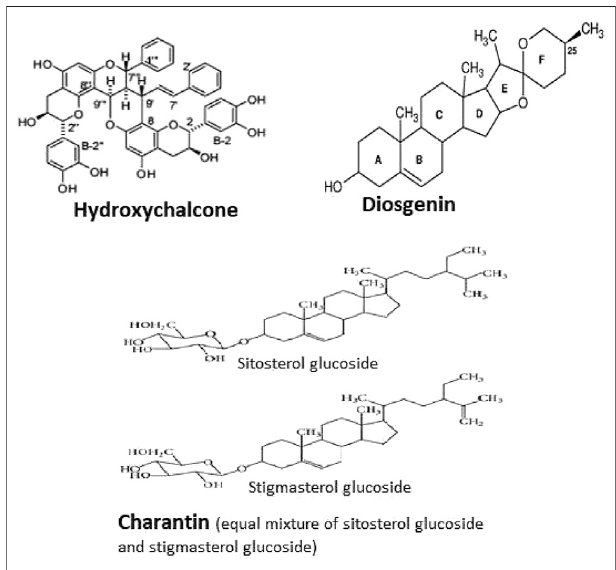
FIGURE 1 | Structure of hydroxychalcone, diosgenin, and charantin.